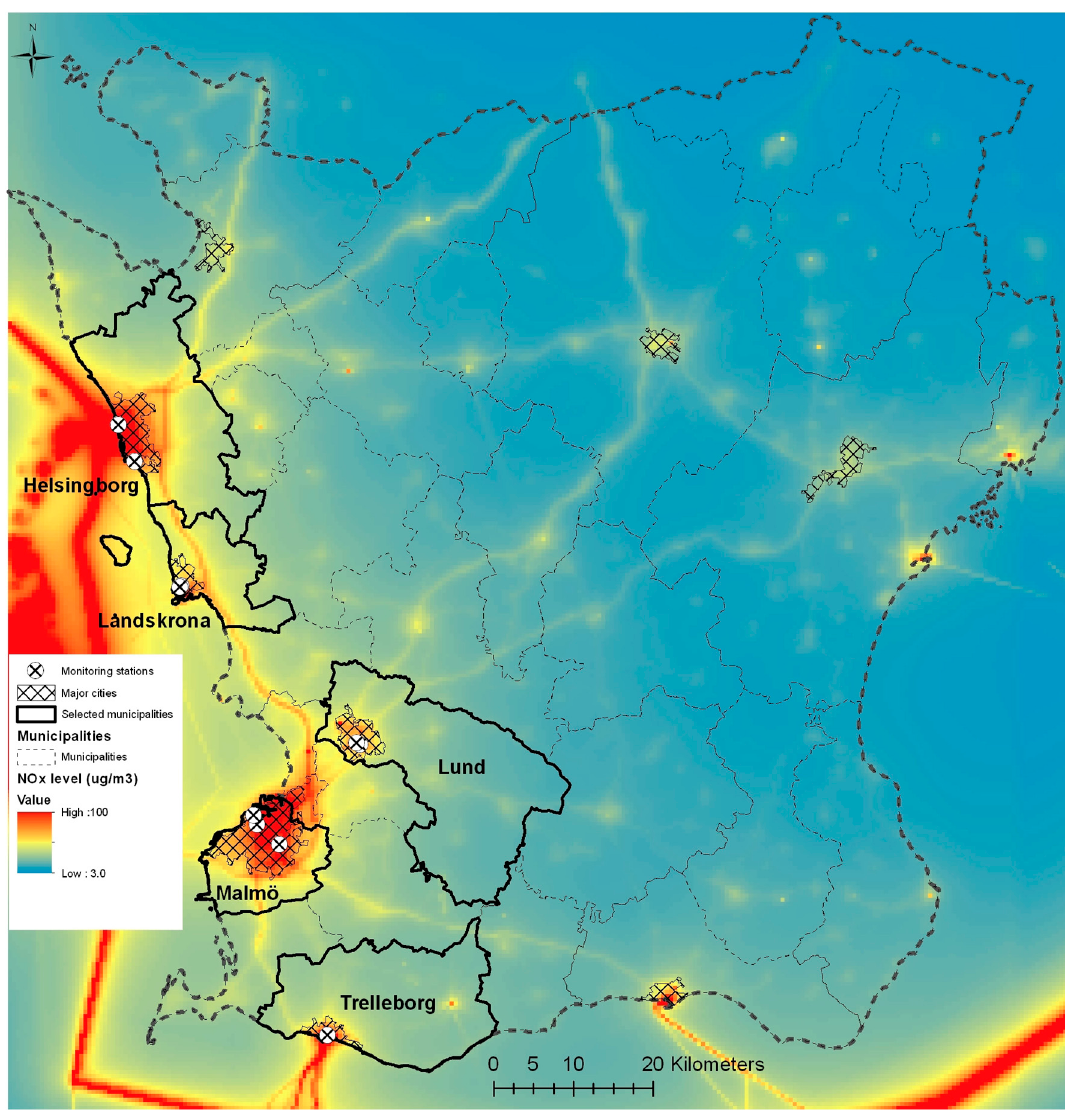
Figure 1. Selected study area and air pollution-monitoring stations. Table 1. Descriptive statistics of air pollution data during the study period (2005–2010).